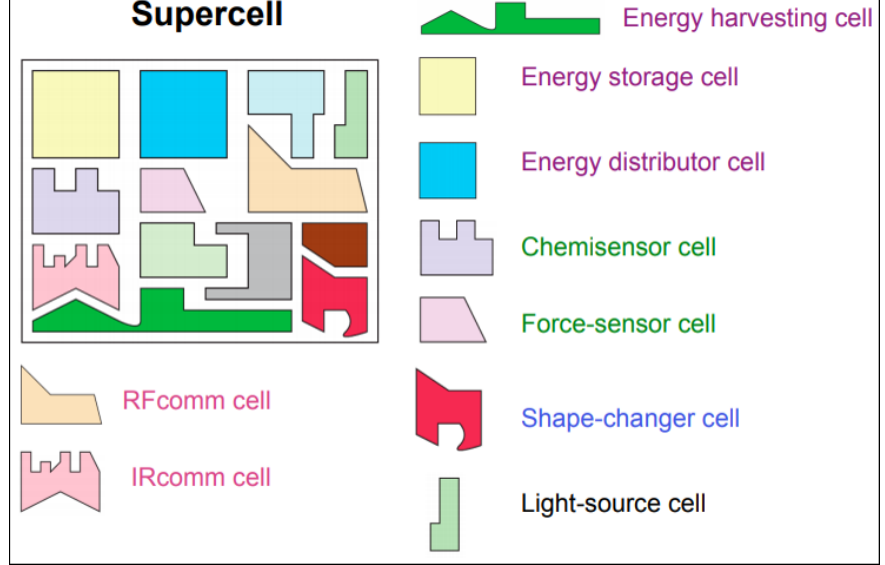
Figure 8. Schematic of the Nanoengineered Metamaterials and Super Cell.